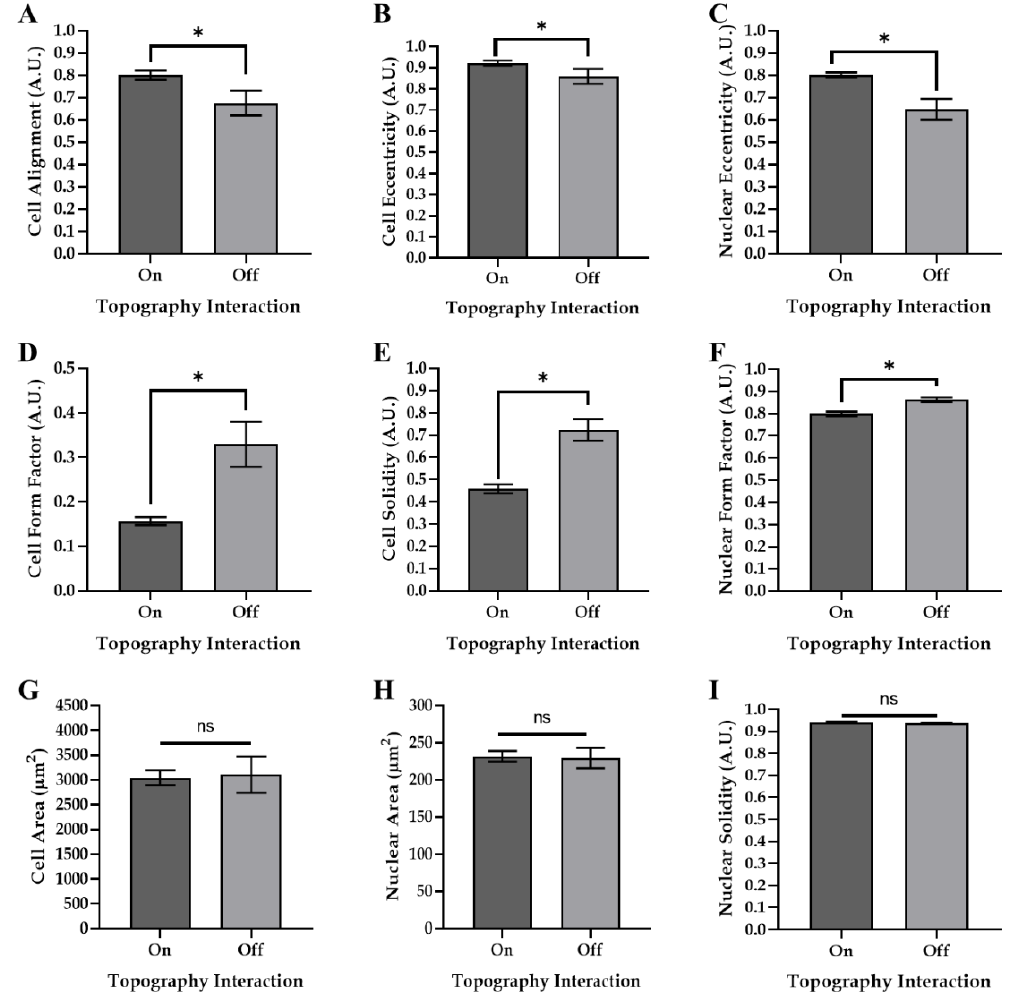
Figure 4. Adhesion to the creased topography influenced cell morphology but not cell size. The impact of cell adherence on and off the creased topographies on ( A ) cell alignment, ( B ) cell eccentricity, ( C ) nuclear eccentricity, ( D ) cell form factor, ( E ) cell solidity, ( F ) nuclear form factor, ( G ) cell area, ( H ) nuclear area and ( I ) nuclear solidity. (‘On’—cells in contact with topographical features/creases; ‘Off’—cells not in contact with topographical features. * indicates p < 0.05; ns indicates no significant differences..